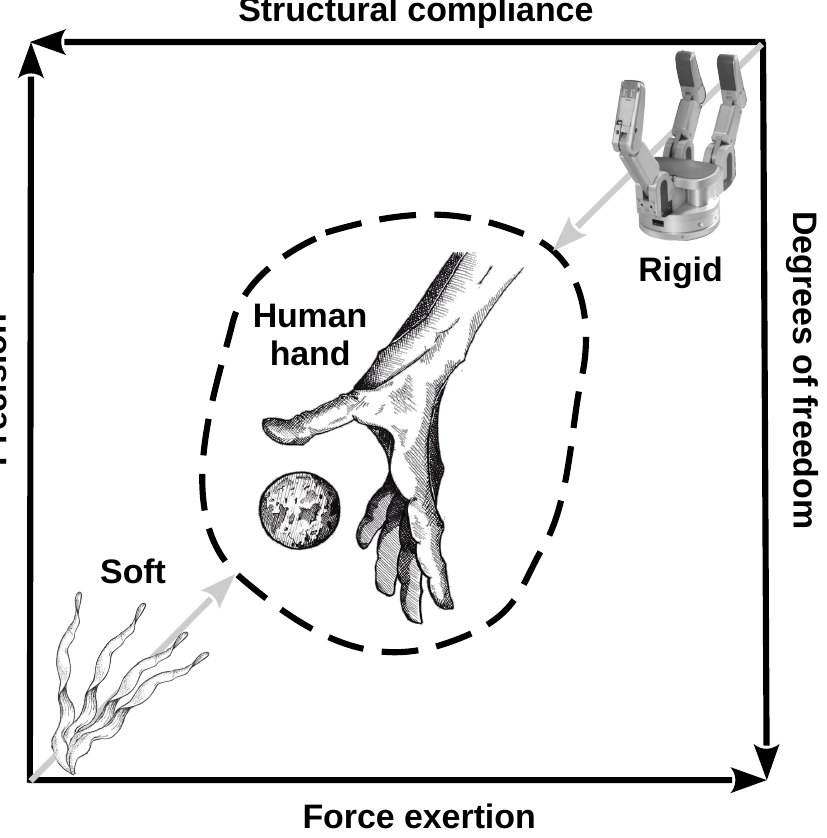
Figure 1. Dependence between the rigidity/softness properties of materials and quantitative func- tionalities of soft actuators (Reprinted/adapted with permission from Ref.